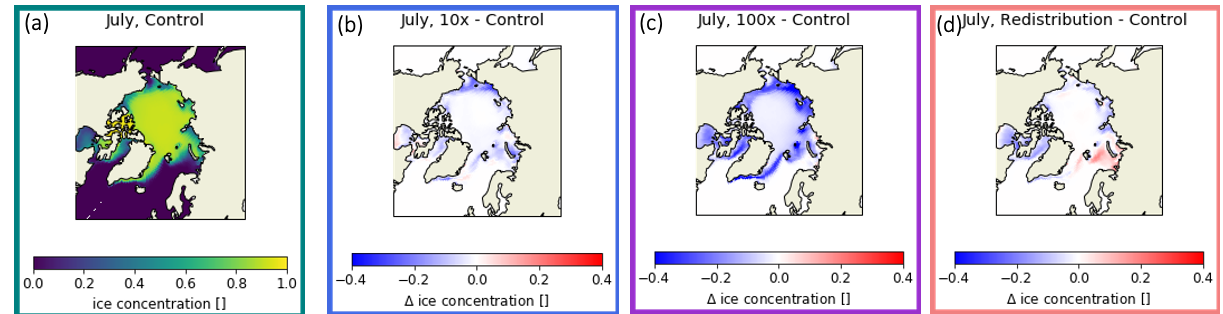
Figure 4. Maps of July Northern Hemisphere sea ice concentration (a) in the control run and relative change in the (b) 10 × , (c) 100 × , and (d) redistributed lateral melt